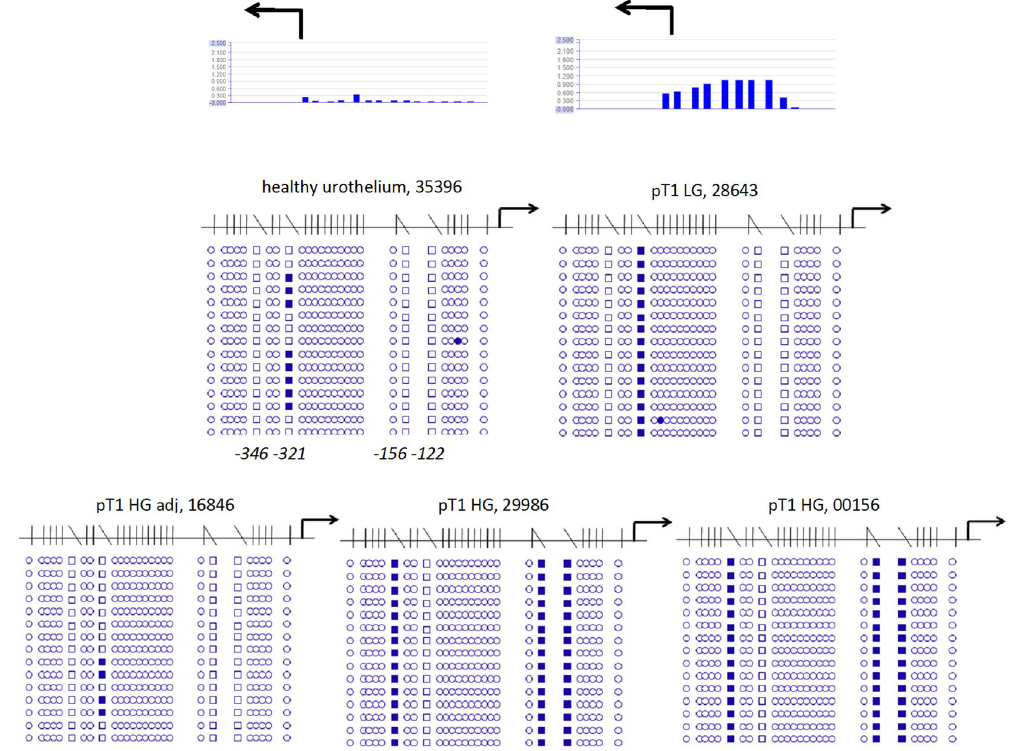
Figure 5. Detailed analysis by bisulfite sequencing of CpG island methylation patterns within 5 ′ regulatory region of MTHFR gene in early urothelium carcinoma. Stage and grade of UC tissue specimens with sample IDs (Table 1) are depicted above the panels. Exemplarily, above the first two panels, two corresponding array results are shown by bar plots. Each blue bar represents a 75 bases long CpG-rich probe on the array. The high of a bar is proportional to the methylation degree. Underneath the detailed CpG methylation profiles of the CpG- rich 5 ′ regulatory region of MTHFR gene are documented as they were revealed by bisulfite sequencing. Filled rectangles stand for methylated cytosine outside the CpG context. White rectangles stand for unmethylated cytosine. White circles stand for unmethylated CpG dinucleotides. Arrows indicate the transcription start site of MTHFR gene. Underneath the upper left panel the positions of the differentially methylated cytosines relative to transcription start site are depicted.